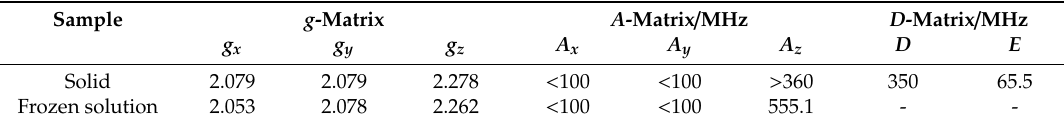
Table 2. EPR spectrum simulation parameters for the frozen solution and solid powder spectra at 77 K.